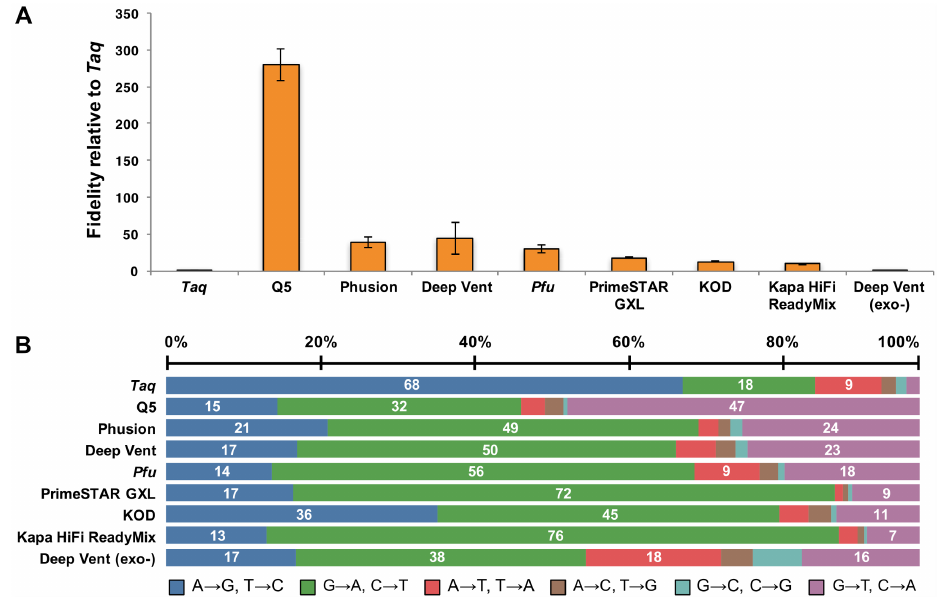
Fig 1. Fidelity measurements and mutational spectrum of DNA polymerases. (A) Base substitutionerror rates of various DNA polymerases relative to Taq polymerase. (B) Proportionof each type of base substitution error as a percentage of the total errors for each